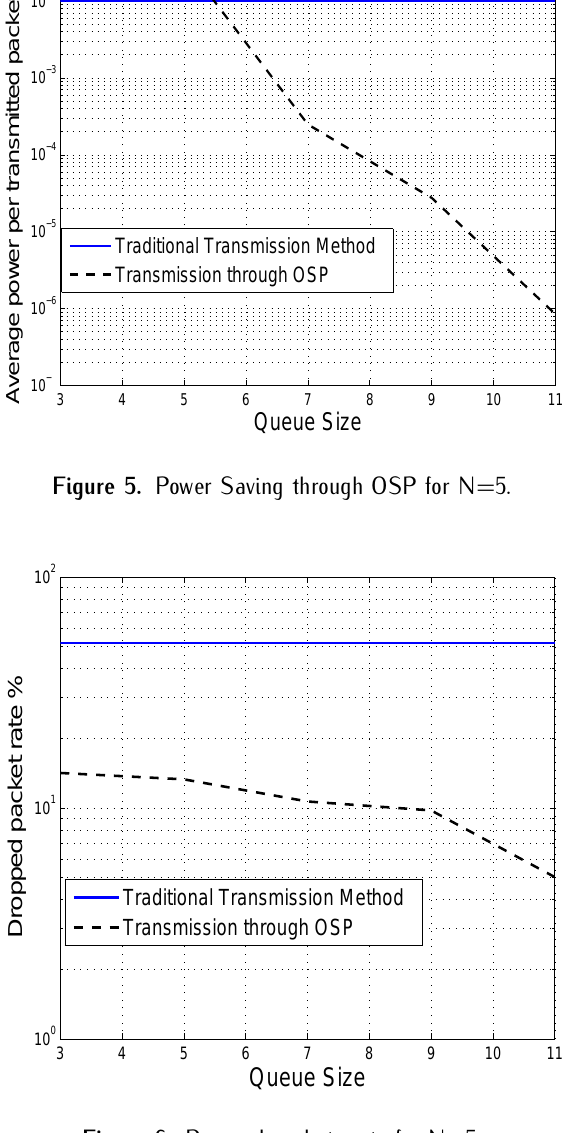
Figure 6. Dropped packets rate for